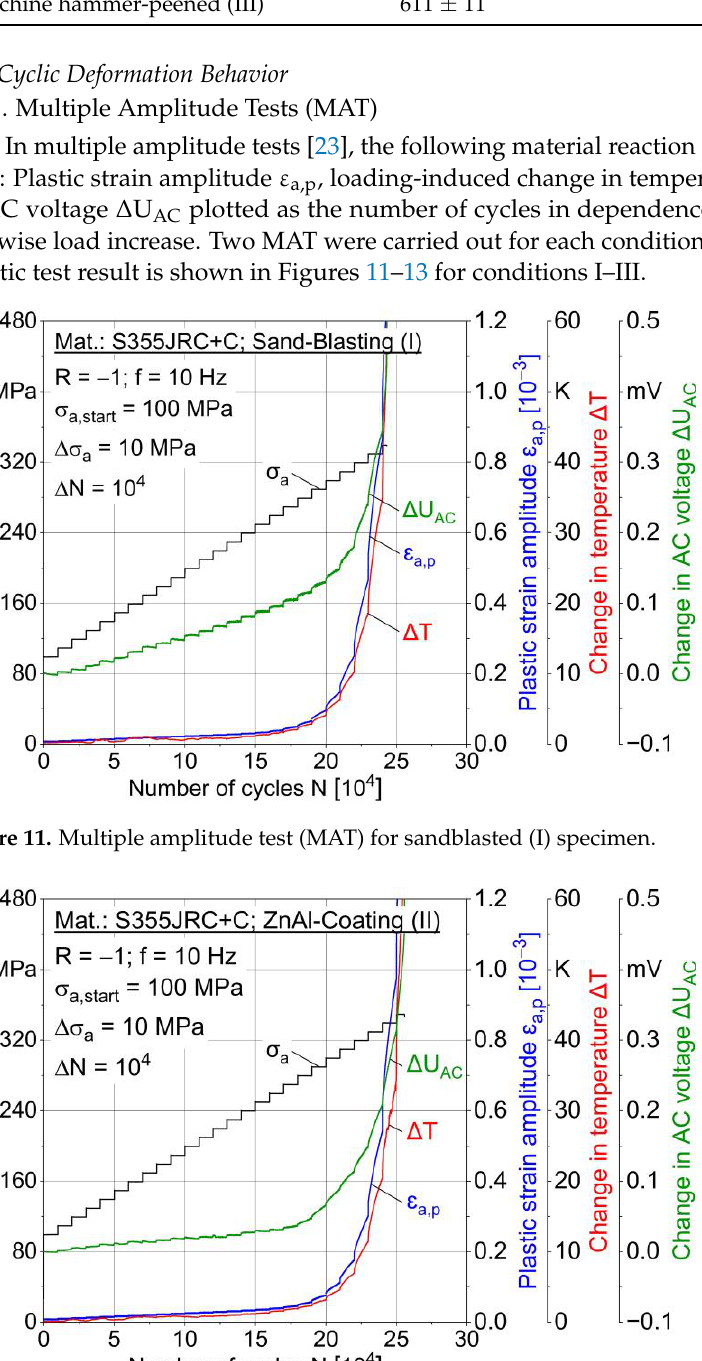
Figure 13. Multiple amplitude test (MAT) for MHP post-treated (III) specimen.